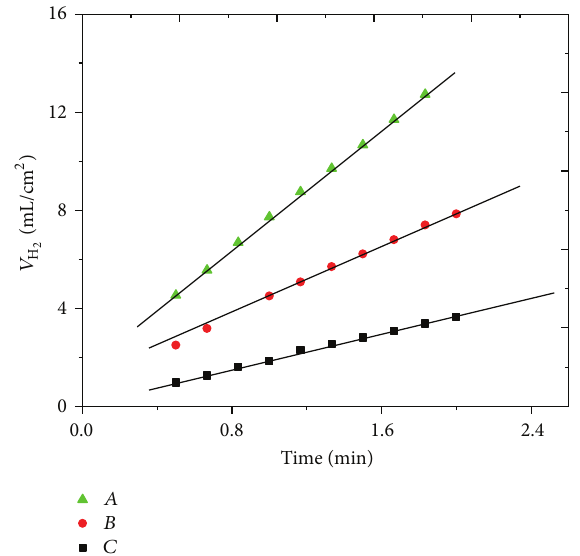
Figure 4: Influence of alginates as inhibitor of corrosion of Al in alkaline media. [OH − ] = 4.0 and I = 4.0 mol dm −3 at 35 ∘ C. 𝐴 : absence of inhibitor; 𝐵 : 0.03 moldm −3 inhibitor; 𝐶 : 0.06moldm −3